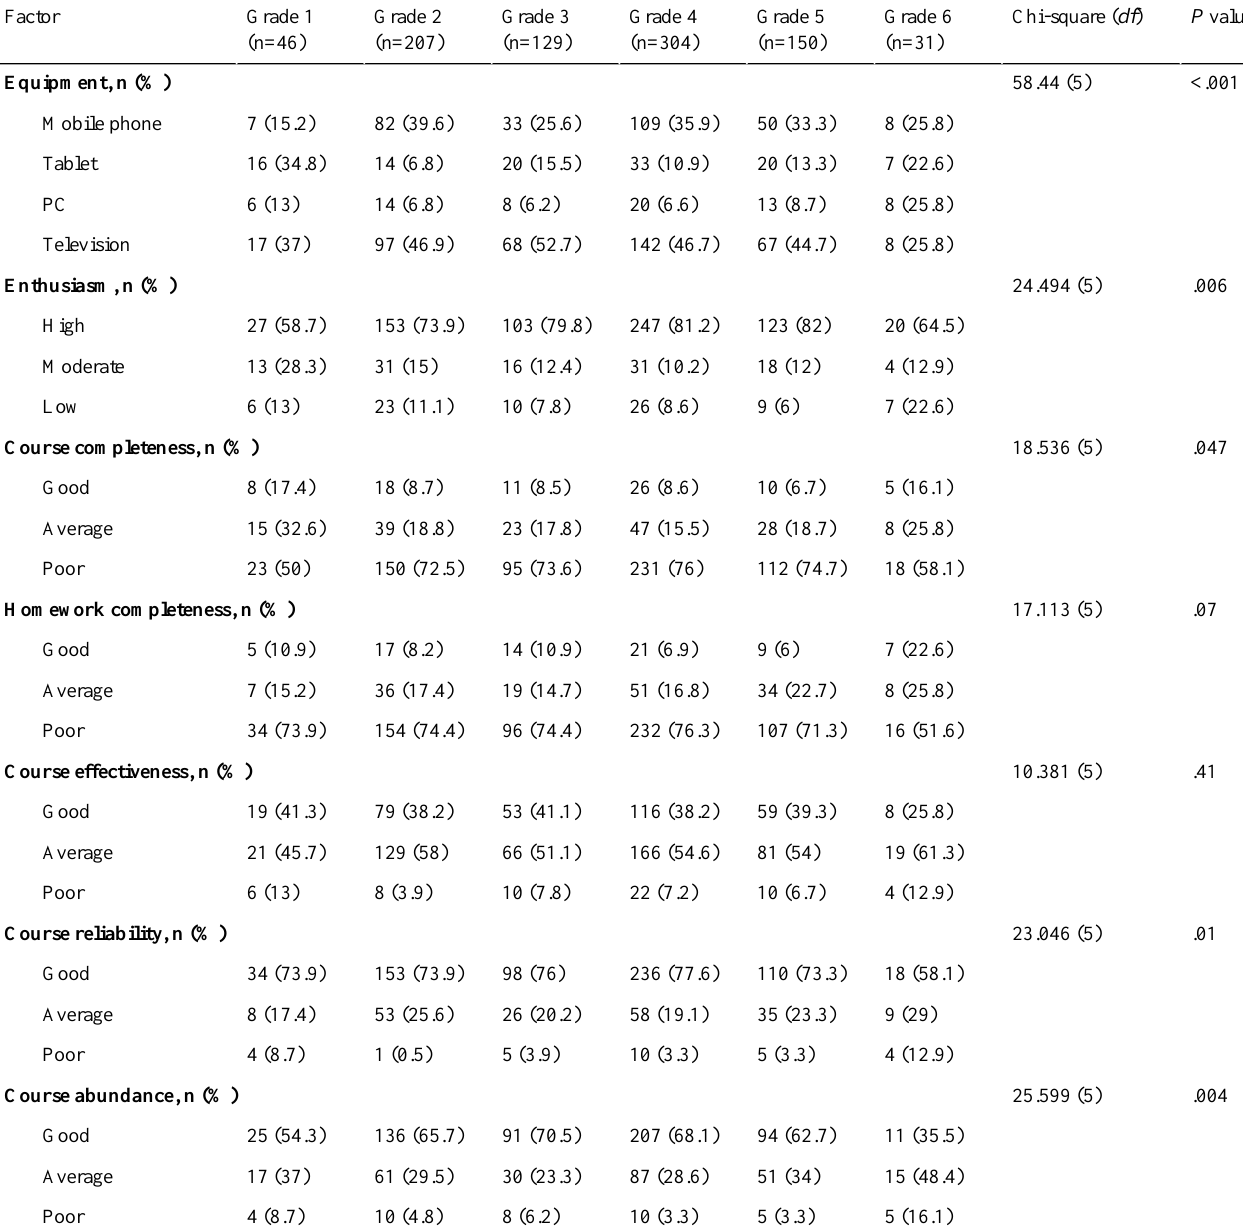
Table 1. Factors affecting student and parental perceptions of online learning at the first stage (10-day